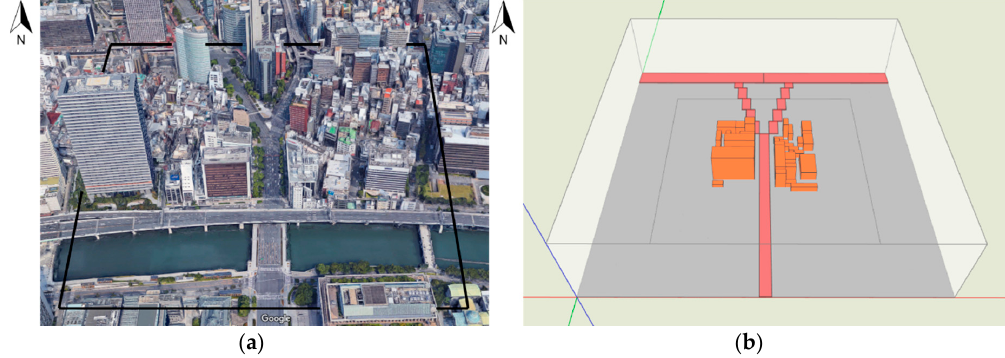
Figure 1. Calculated domain ( a ) Umeda-Shinmichi, Google Maps 2018 (34.70 ◦ N, 135.50 ◦ E); ( b ) computational fluid dynamics (CFD) representation of the three-dimensional city block.